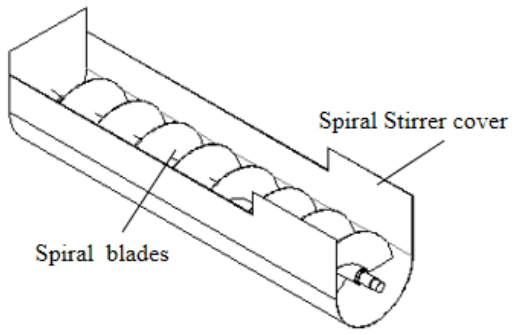
Figure 4. Schematic diagram of the structure of screw conveying device.